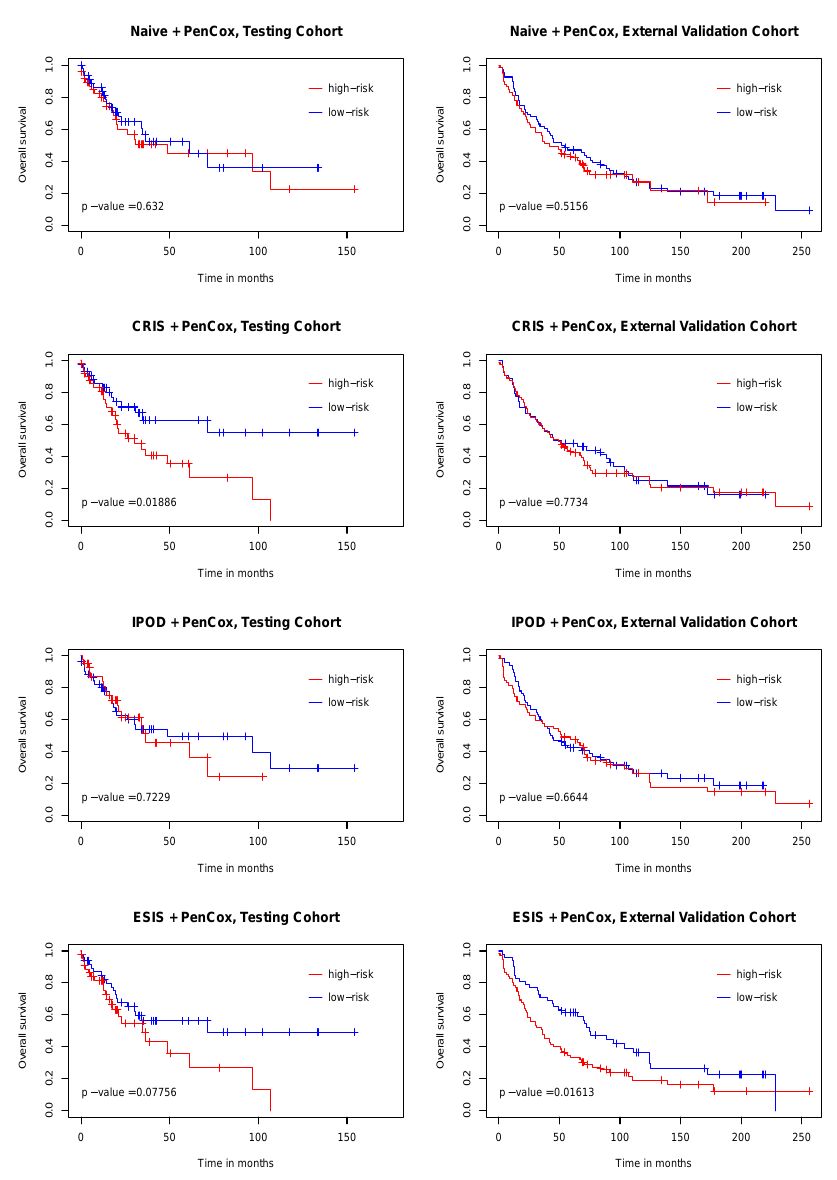
Figure 2. Kaplan–Meier curves of overall survival for test (TCGA) and validation (GEO) cohorts varying with the risk level determined by the four competing models. p -values were obtained from the log-rank tests contrasting the two risk